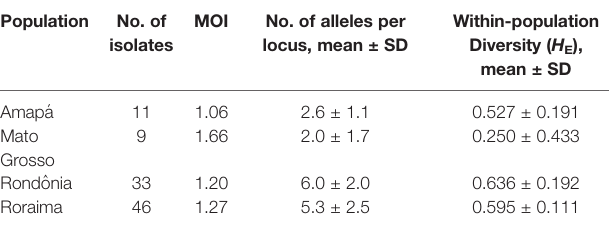
FIGURE 3 | Comparison between protocols used in this study for the assessment of pfhrp2 and fl anking gene deletions. Absolute values are shown on bars. Gray: results of pfhrp2 deletion based on Protocol 1 (conventional PCR using the primers described by Baker et al., 2005 and Gamboa et al., 2010); black: results of pfhrp2 deletion based on Protocol 2 (nested PCR using the primers described in Abdallah et al., 2015). N = 129. TABLE 3 | Proportion of multiplicity of infection and genetic diversity of Plasmodium falciparum populations from 4 endemic areas of the Brazilian